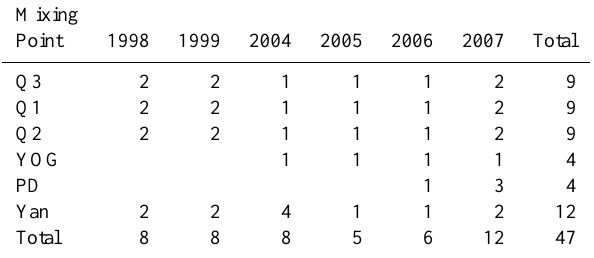
Table 2. Description of dry season yearly samplings performed at the Querococha basin between 1998 and 2007. Blanks indicate no data